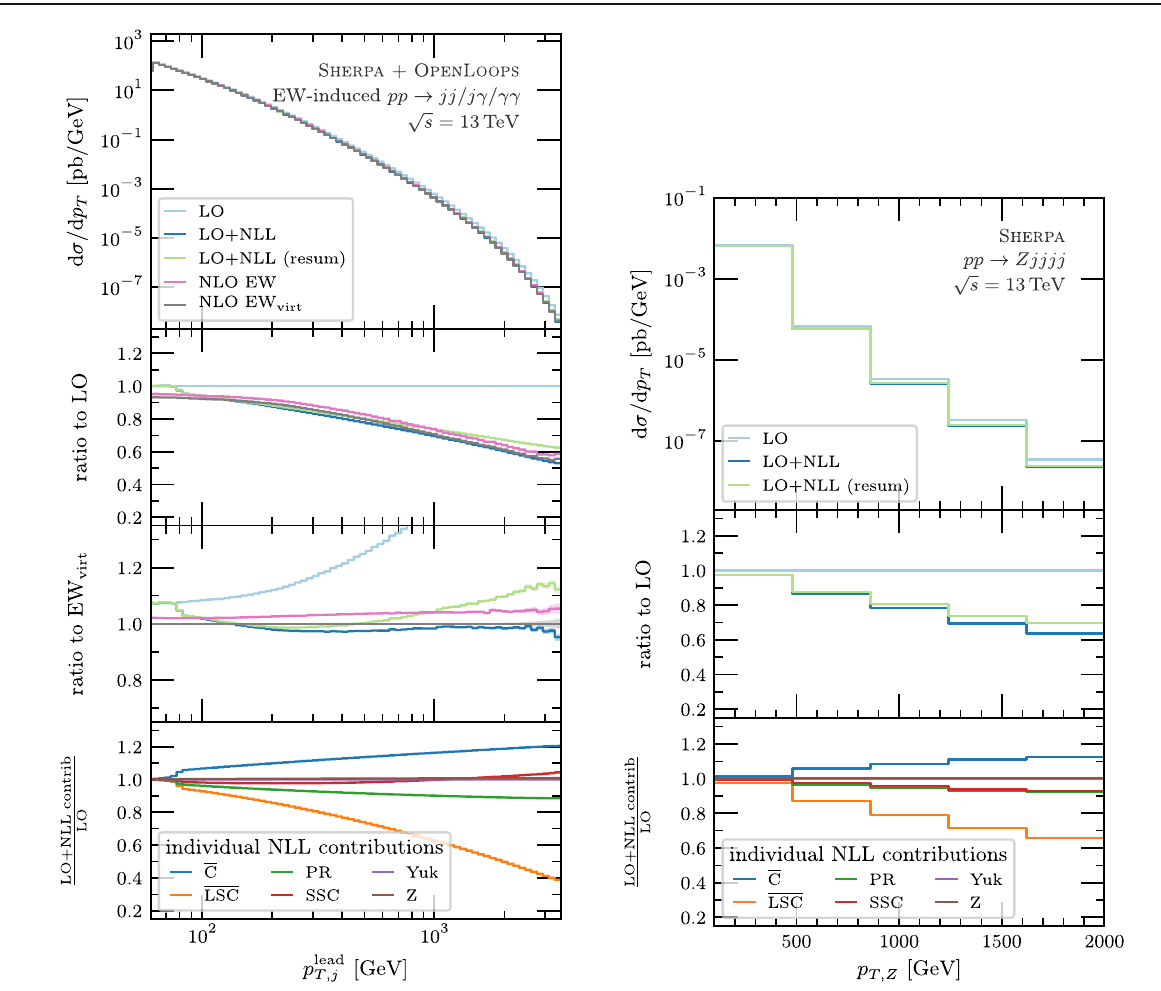
Fig. 3 The transverse momentum of the leading jet in EW-induced dijet production in proton–proton collisions (including photon chan- nels), and for the reconstructed Z boson in e + e − plus four jets pro- duction, For the dijet production, LO and NLO calculations are shown, whereas for the Z plus jets production only the LO is shown. These